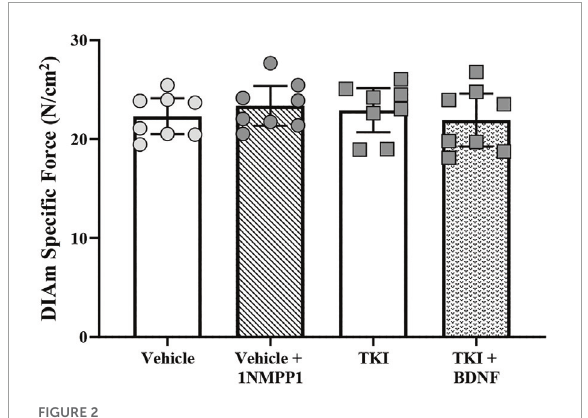
FIGURE2 Unchanged isometric specific force in TrkB F 616 rat DIAm treated acutely (in bath) or chronically (14 days) with 1NMPP1. Plot (mean ± 95% CI) illustrating increased final DIAm isometric specific force of vehicle + 1NMPP1, TKI and TKI + BDNF compared to vehicle rats (one-way ANOVA, Tukey’s post-test). N = 8 rats per group. Stimulations at 40 Hz reflect ∼ 80% of